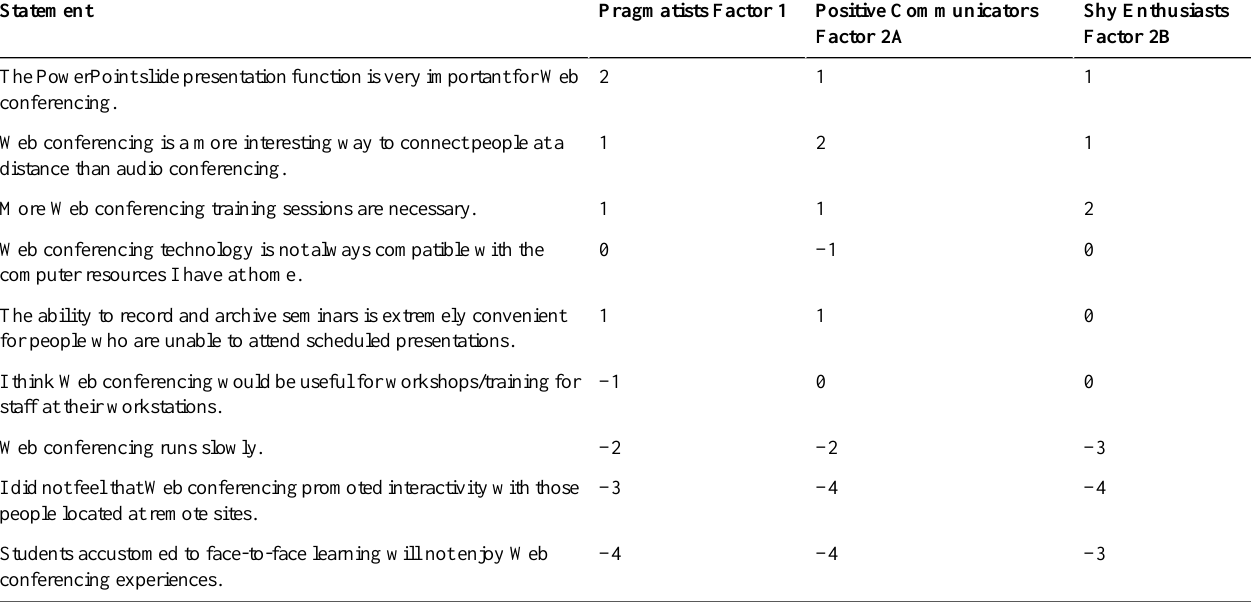
Table 6. Consensus statements*